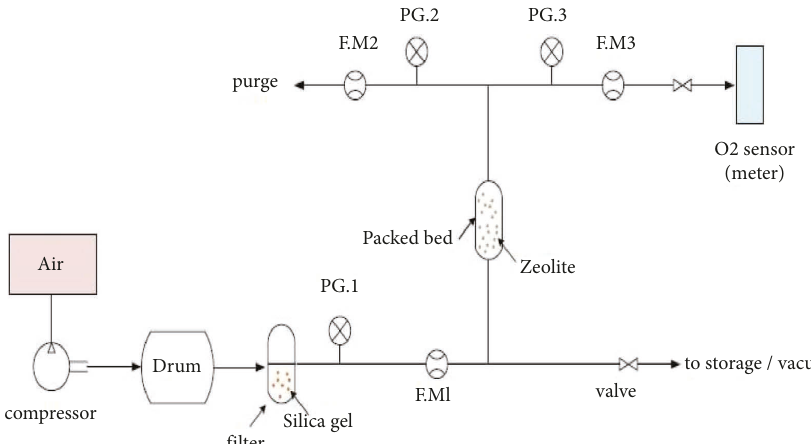
Figure 2: Schematic diagram of experiment Table 3: Experimental design of BBD for the production of oxygen. Run Pressure